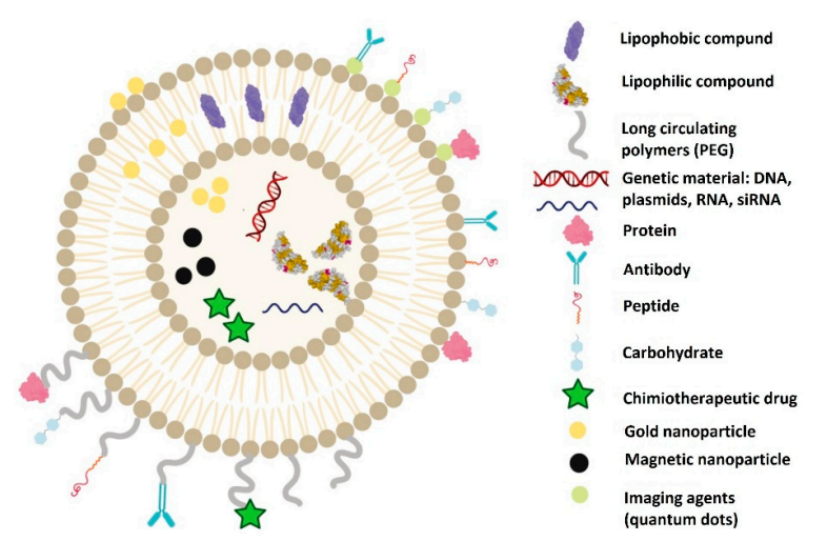
Figure 1. Structure of liposomes and the molecules that can be delivered through them. Attempts were made to immobilize liposomal BMP-2 onto different biocompatible scaffolds for a sustained, long-term release. Electrospun poly(L-lactic acid) fibers, func- tionalized with hydroxyapatite (HA) can be a good carrier for BMP-2 loaded liposomes. Adipose tissue-derived MSCs were seeded onto the scaffolds. The levels of ALP